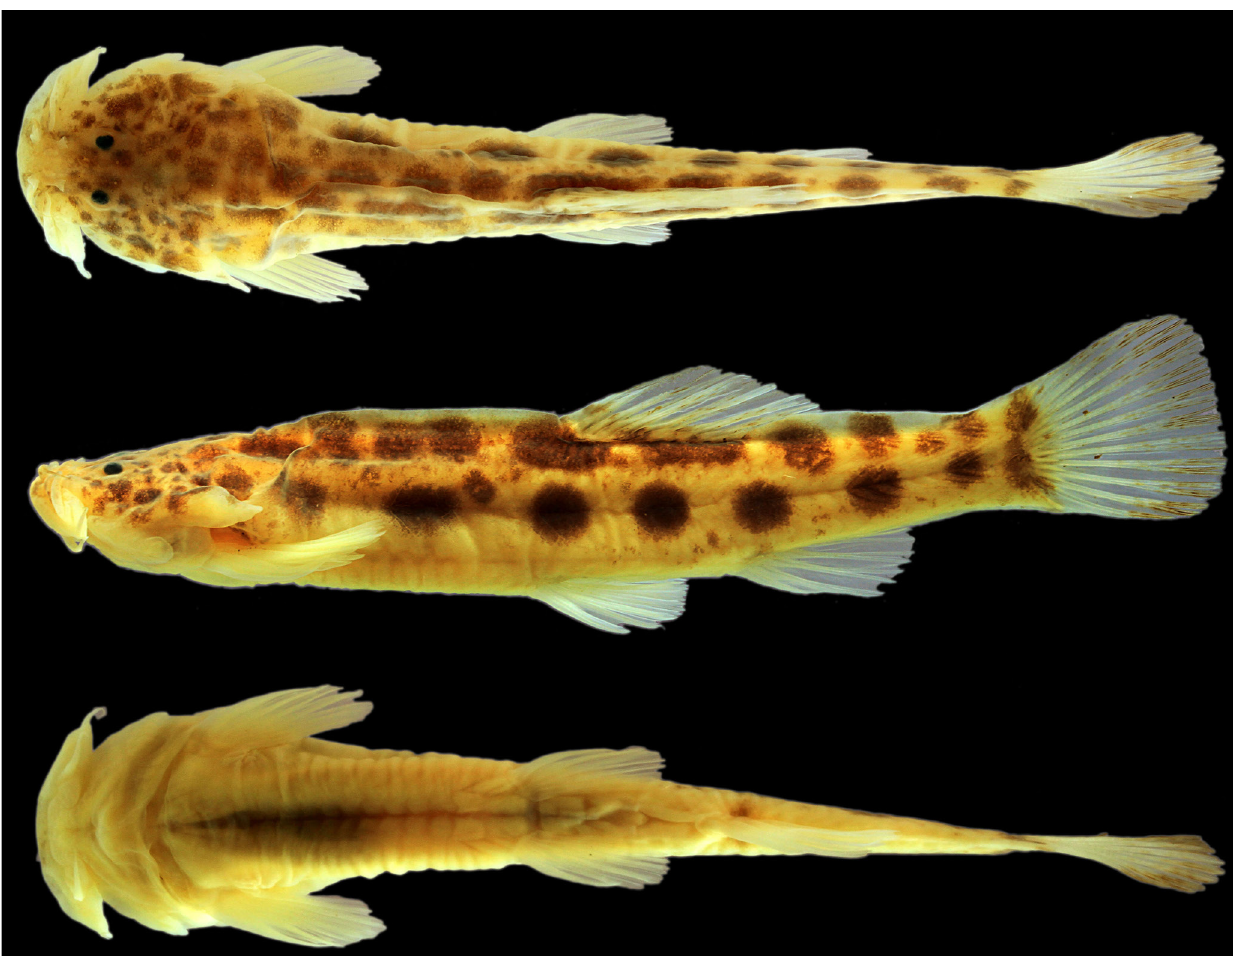
FIGURE 9 | Scleronema macanuda , new species, holotype (MCN 20230; 71.8 mm SL), Brazil, Rio Grande do Sul Sentinela do Sul, irrigation water channel draining to arroio Velhaco, laguna dos Patos